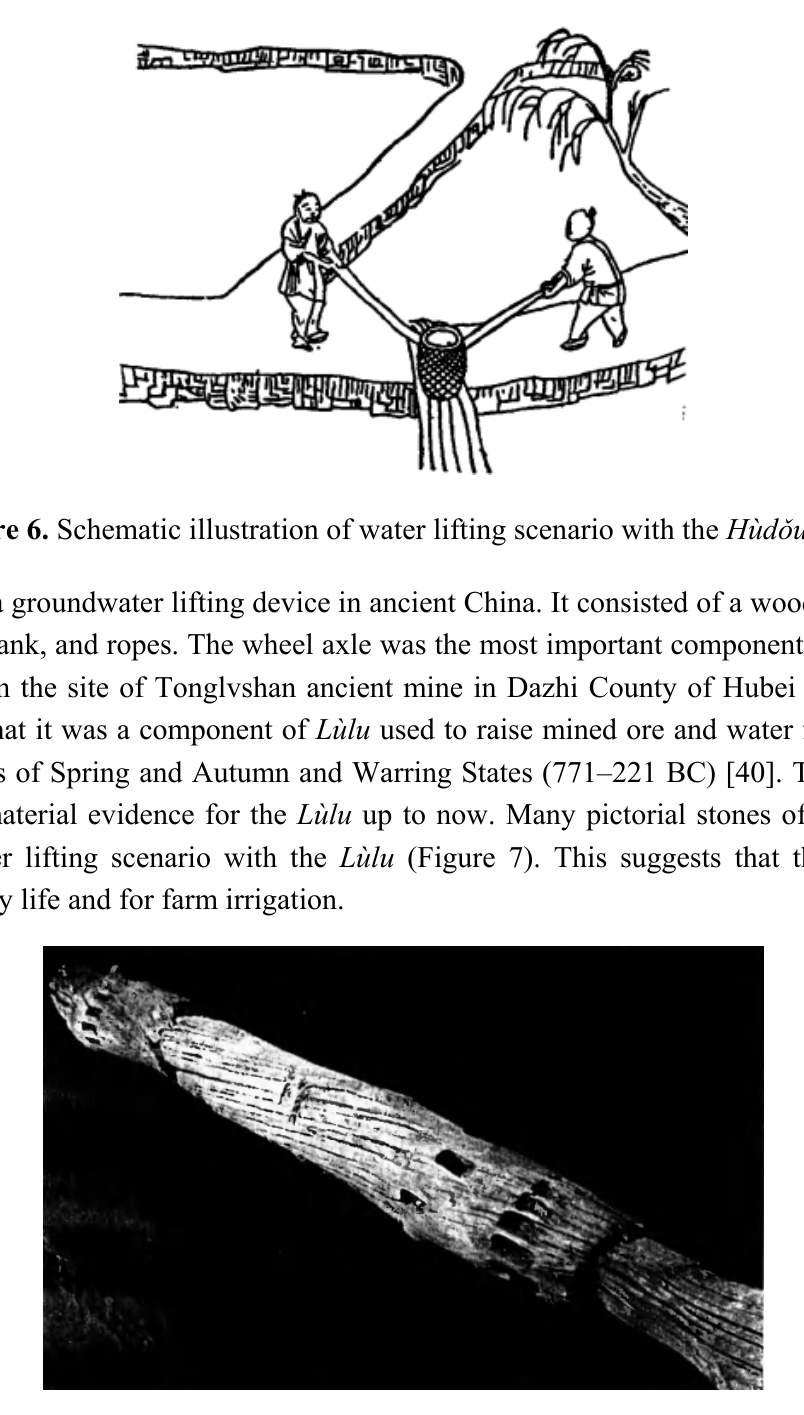
Figure 7. A wooden wheel axle of the Lùlu at the site of Tonglvshan ancient mine ([20]